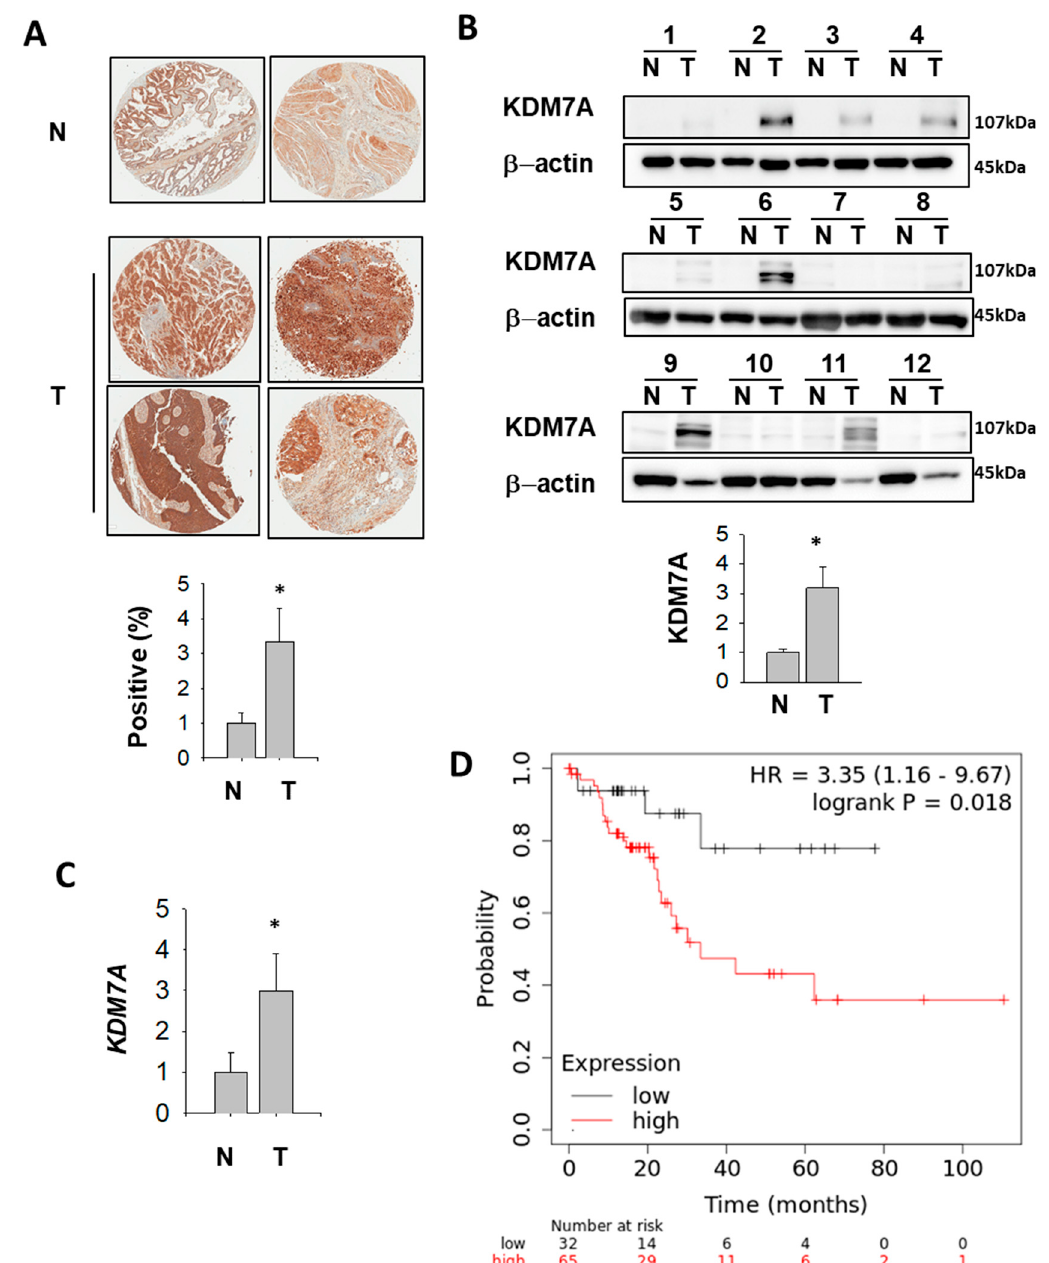
Figure 8. KDM7A is up-regulated in bladder cancer patients ( A ) Representative images of KDM7A expression in bladder tumor and normal tissue arrays (upper figures). N, normal bladder tissue; T, bladder tumor tissue. The expression level of KDM7A from 25 different bladder tumors and 6 normal tissues were calculated and plotted (below graph). * p < 0.05 (Student’s t -test) between two groups. ( B ) Bladder tumor (T) and adjacent normal (N) tissues were subjected to Western blotting using the KDM7A and beta actin antibodies. Protein bands were analyzed densitometrically and protein levels normalized to beta actin levels were plotted in the lower graph. * p < 0.05 (Student’s t -test) between two groups. ( C ) Comparison of KDM7A mRNA expression levels between normal and tumor bladder tissues. * p < 0.05 (Student’s t-test) between two groups. ( D ) A survival curve was plotted for male bladder cancer patients with cancer stage 2 ( n = 97). Data were analyzed using the Kaplan–Meier Plotter (www.kmplot.com). Patients with expression above the median are indicated in red line, and patients with expressions below the median in black line. HR means hazard ratio.